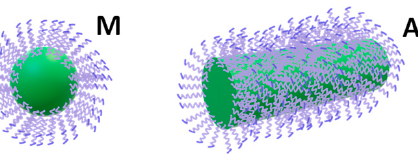
Figure 5. Spherical micelle (M) and worm-like aggregate (A) with the same diameter as a micelle.